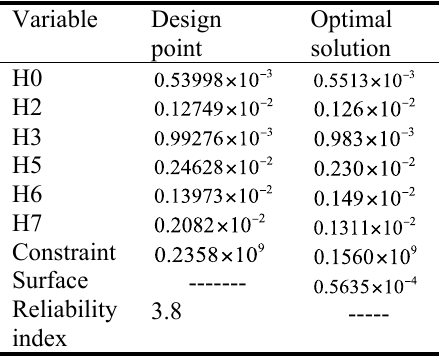
Table 5. Results of the OSF